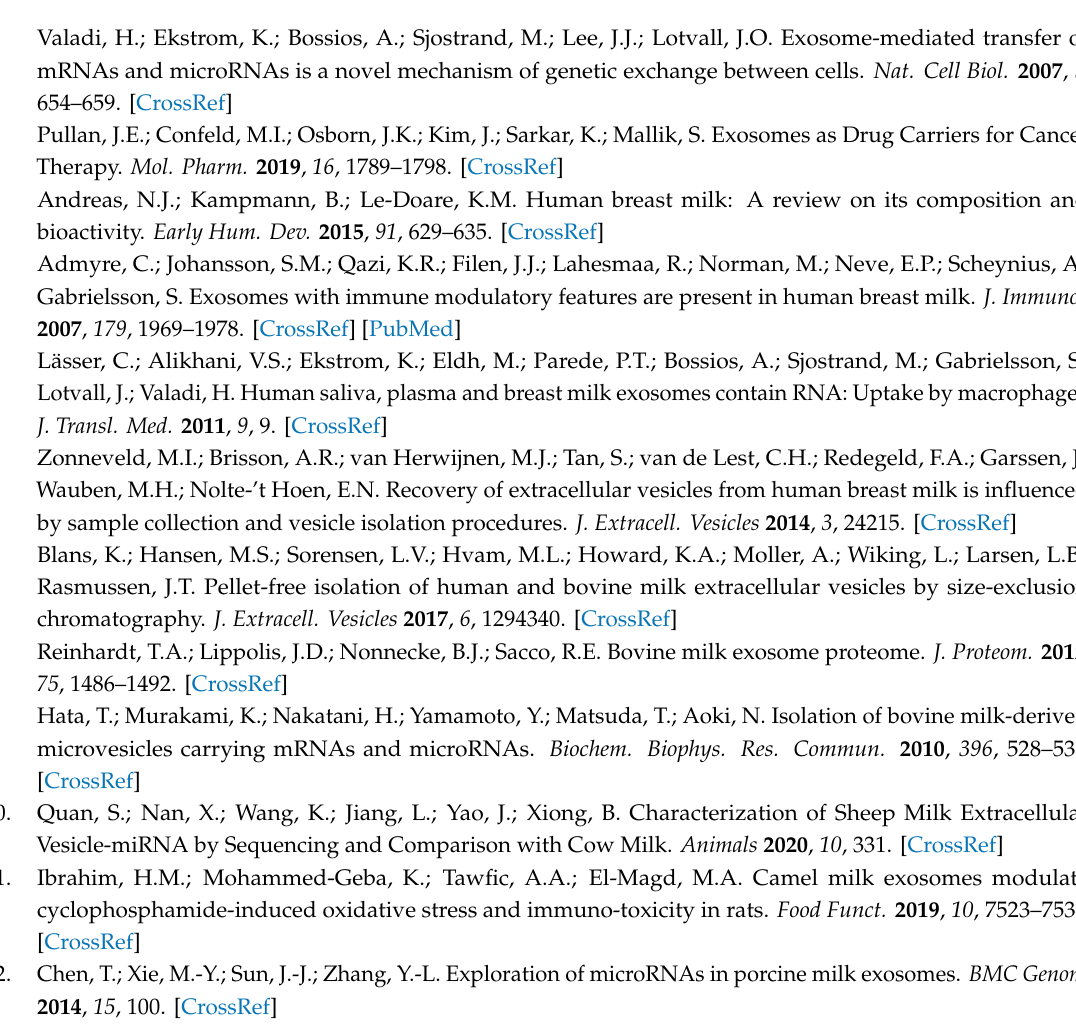
Figure S1: Separation of EVs from major skim milk